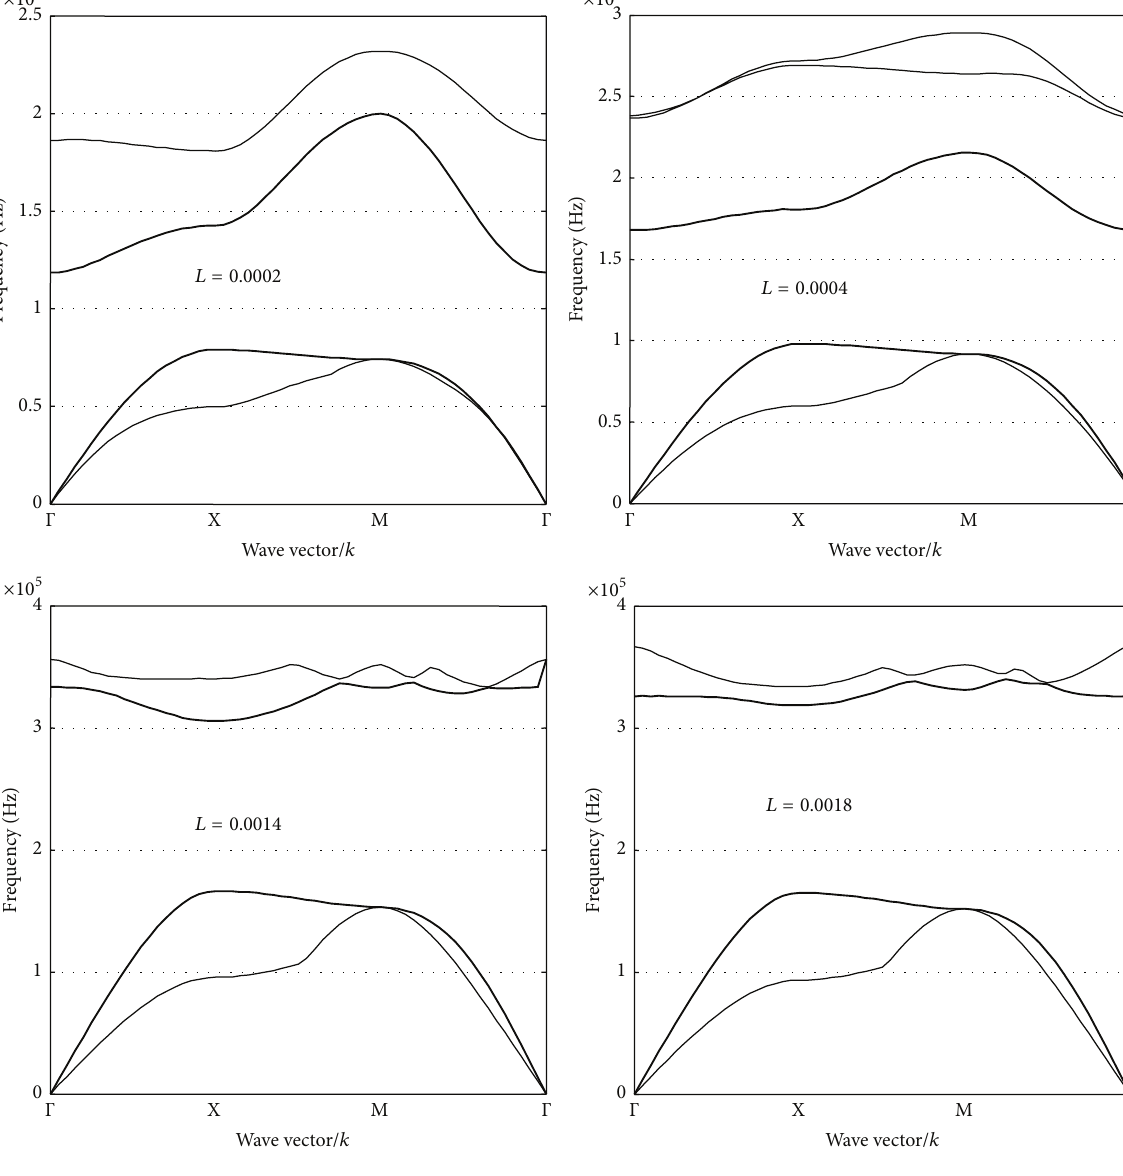
mass-spring system increases rapidly, while the mass of the resonator has no change, resulting in the resonance frequency minor declining